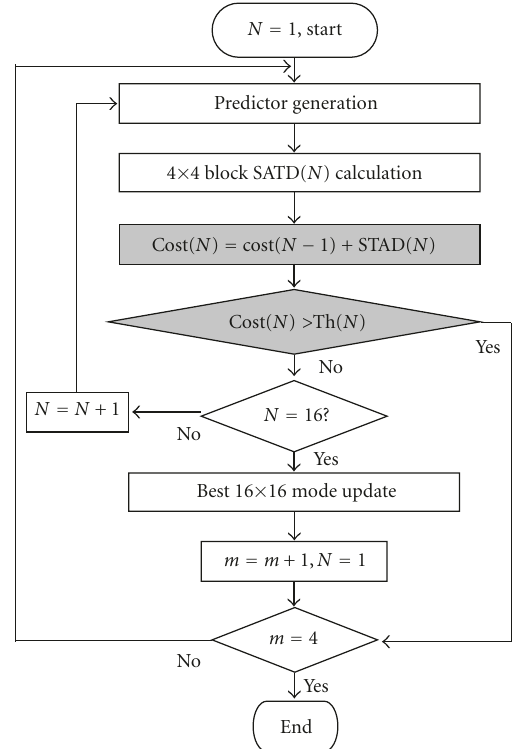
Figure 2: Early termination of 16 × 16